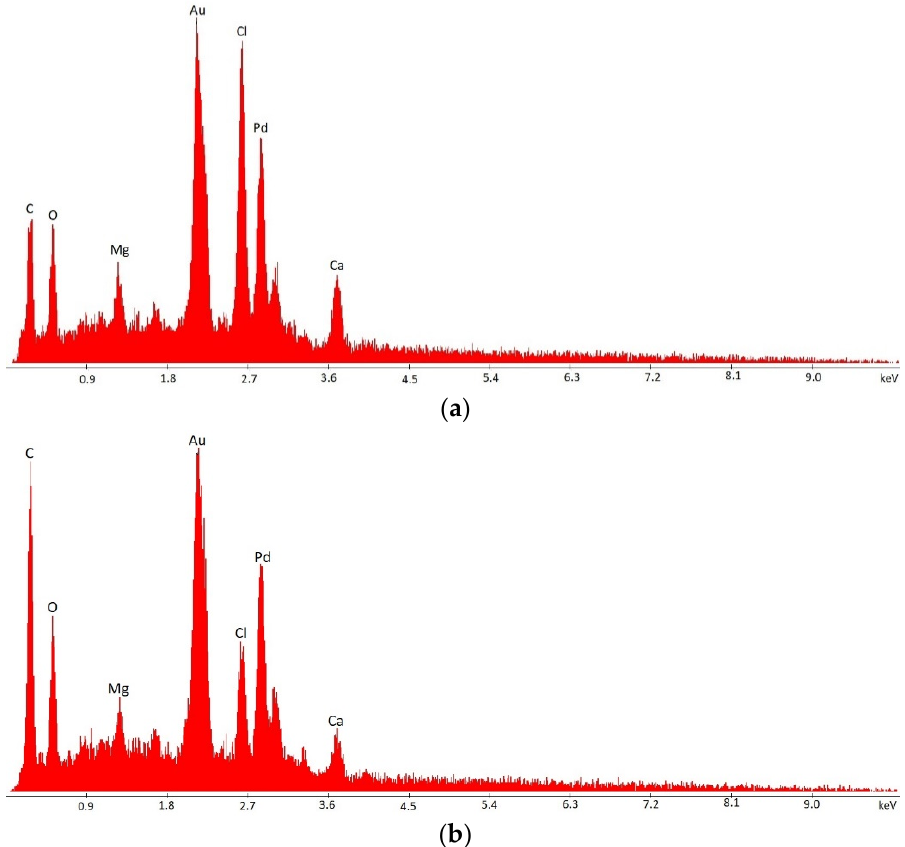
Figure 5. Surface composition SEM analysis of T18 yeast encapsulated in ( a ) Ca-alginate beads and ( b ) Ca-alginate/chitosan beads.